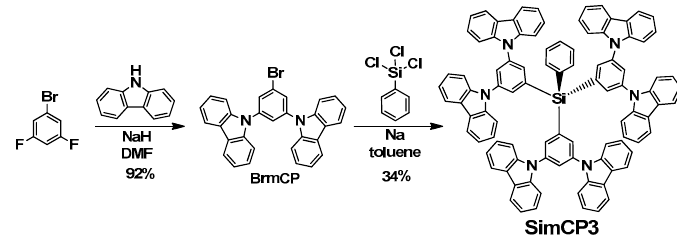
Figure 1. TGA ( a ) and DSC ( b ) thermograms of SimCP3 .